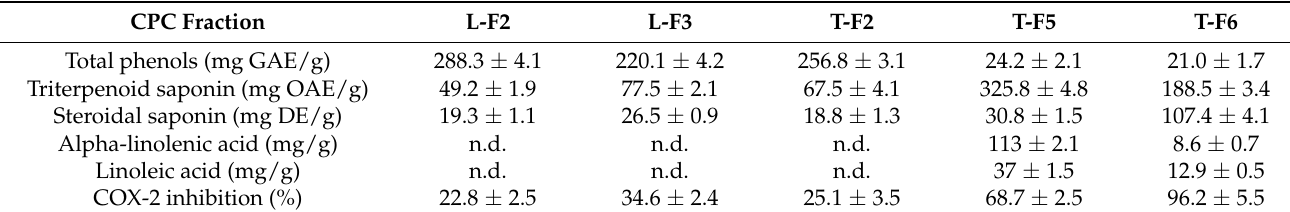
Table 4. Phytochemical composition in mg/g dry sample and relative COX-2 inhibition to control (%) of the Waltheria indica leaf extract fractions. Data points represent the mean value ± standard deviations of three samples. GAE = Gallic acid equivalent; OAE = Oleanolic acid equivalent; DE = Diosgenin equivalent; n.d., not detected. CPC Fraction L-F2 L-F3 T-F2 T-F5 Total phenols (mg GAE/g) 288.3 ± 4.1 Triterpenoid saponin (mg